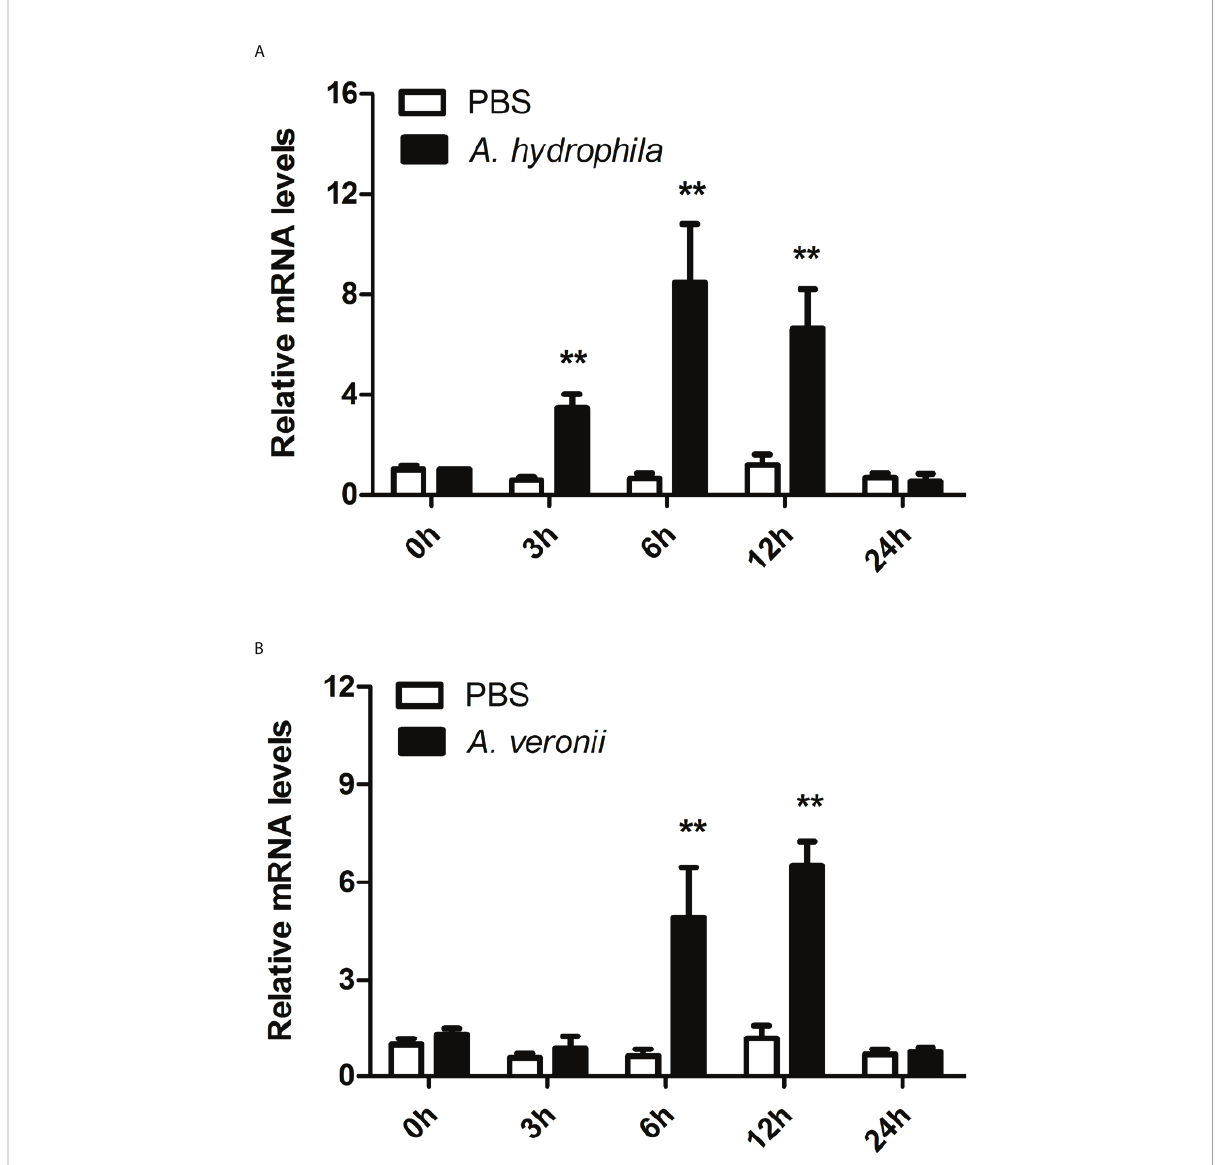
FIGURE 7 Temporal expression pro fi les of Ci MEKK3 mRNA in intestinal cells after challenge with A. hydrophila (A) or A veronii (B) . Each bar represents the mean of the normalized expression levels of replicates ( N = 3). Signi fi cant differences between the challenge group and the control group are indicated with an asterisk (** represents P <